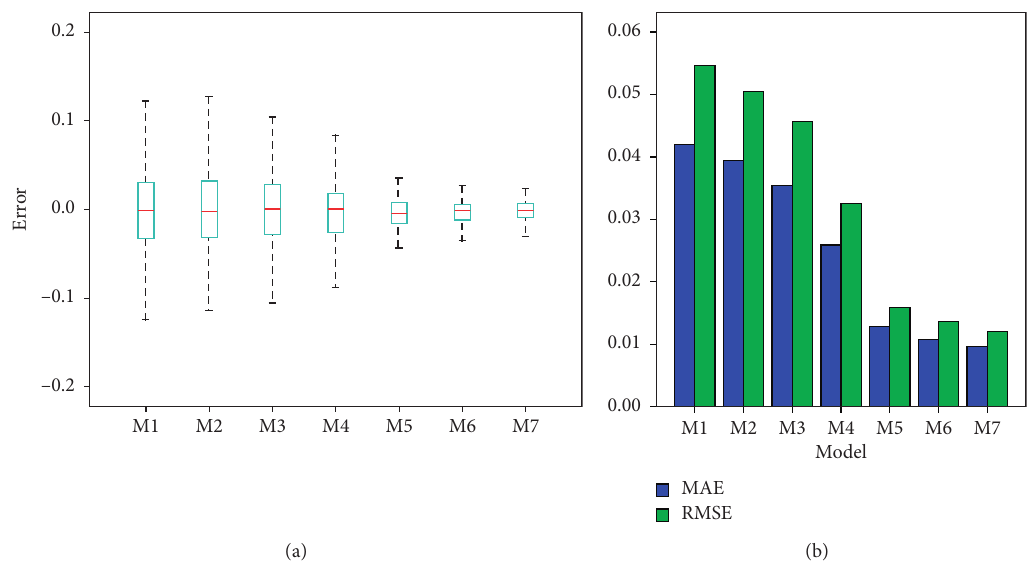
Figure 17: (a) Error box diagram of each model; (b) bar chart of model error index. M1: SVR; M2: ELM; M3: ASVR; M4: EMD-ASVR; M5: VMD-ASVR; M6: VMD-DE-ASVR; M7: VMD-DE-ELM-ASVR.